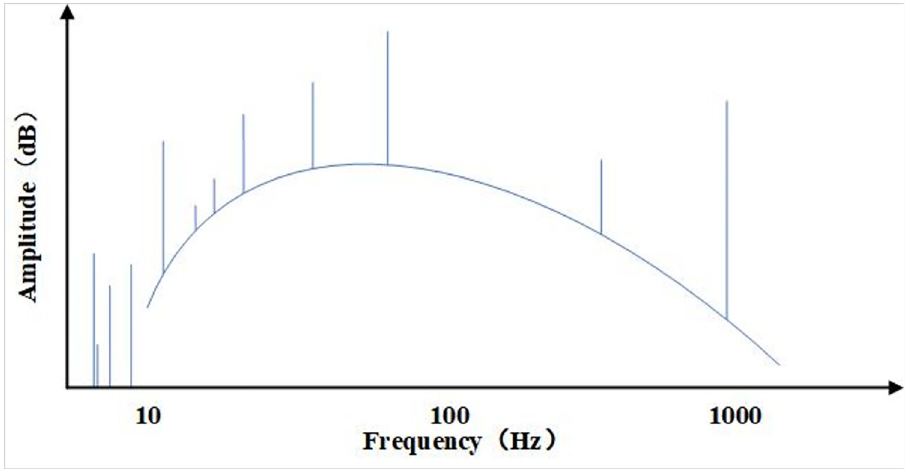
Fig 8. Schematic diagram of the composition of the ship’s radiated noise